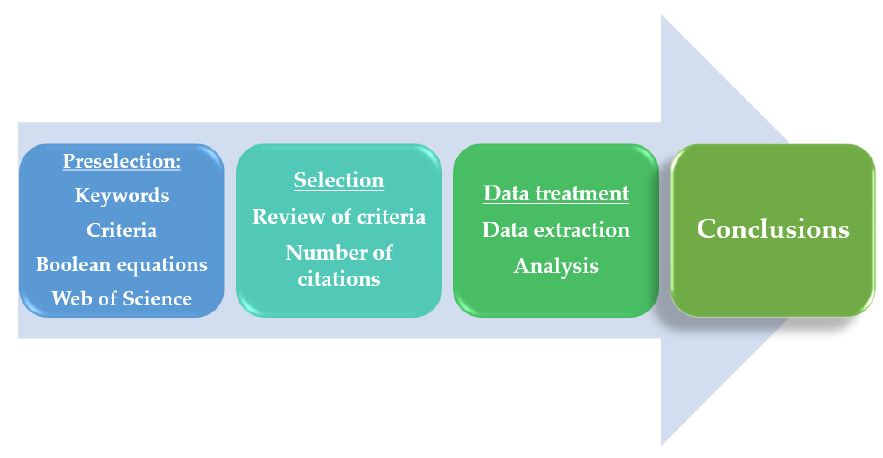
Figure 1. Stages of the applied methodology.